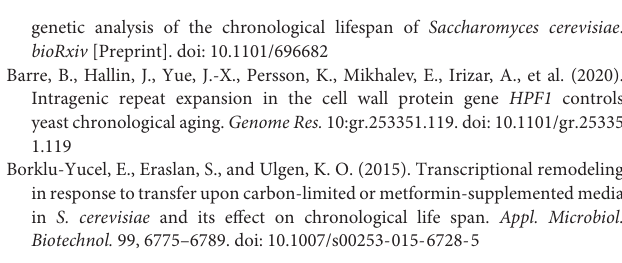
FIGURE S1 | Examples of raw data for OD 600 , and RFPraw and CFPraw signal from outgrowth-culture kinetics monitored throughout the experiment. FIGURE S2 | Multiple linear modeling fits relative survivorship and relative growth rate from competitive-aging cultures. FIGURE S3 | Comparing replicability of CLS measurements from two methods. FIGURE S4 | Variation in S decreases with the number of reference samples used. FIGURE S5 | The parameter G corrects effects of differential growth rates that otherwise affect relative survivorship, S . FIGURE S6 | Metformin limits media acidification in stationary phase. FIGURE S7 | Relative survivorship (S) is well replicated between plates within the same experimental batch, as well as between different batches. FIGURE S8 | The parameter G corrects effects of differential growth rates that otherwise affect relative survivorship, S . FIGURE S9 | Relative survivorship ( S ) data rescaling. FIGURE S10 | Candidate gene-drug interactions and validation. TABLE S1 | Recipes for media used in this